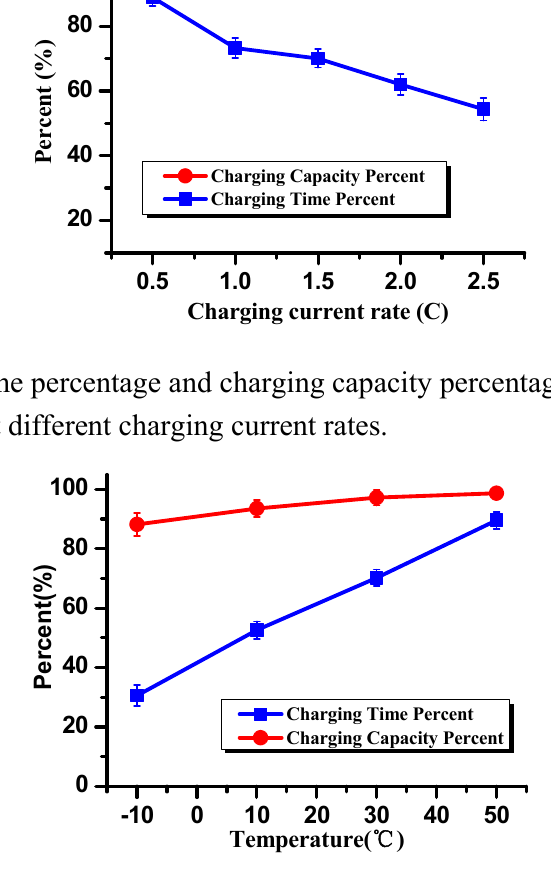
Figure 4. Charging time percentage and charging capacity percentage between CC strategy and CC/CV strategy at different temperatures.